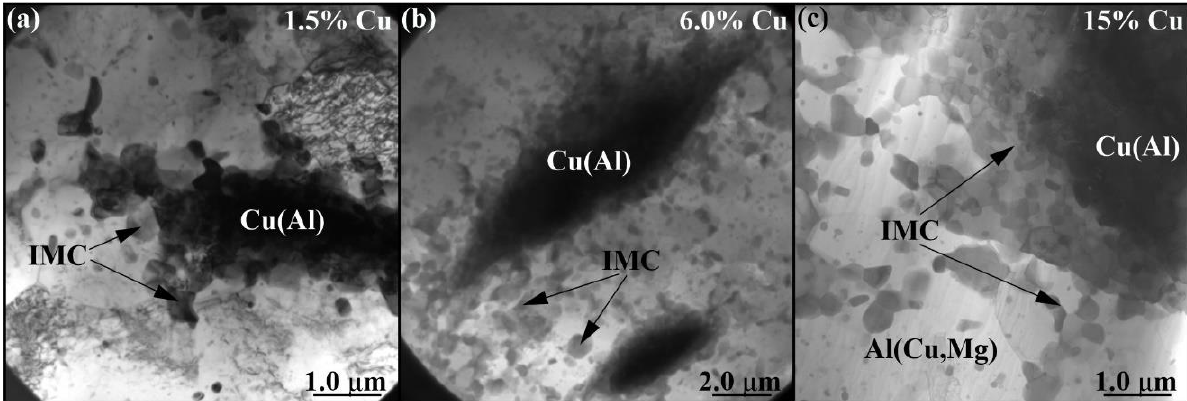
Figure 14. The bright-field TEM images of IMC agglomerate particles in the 4-pass samples after FSP with 1.5 vol.% ( a ), 6.0 vol.% ( b ) and 15 vol.% Cu ( c ).